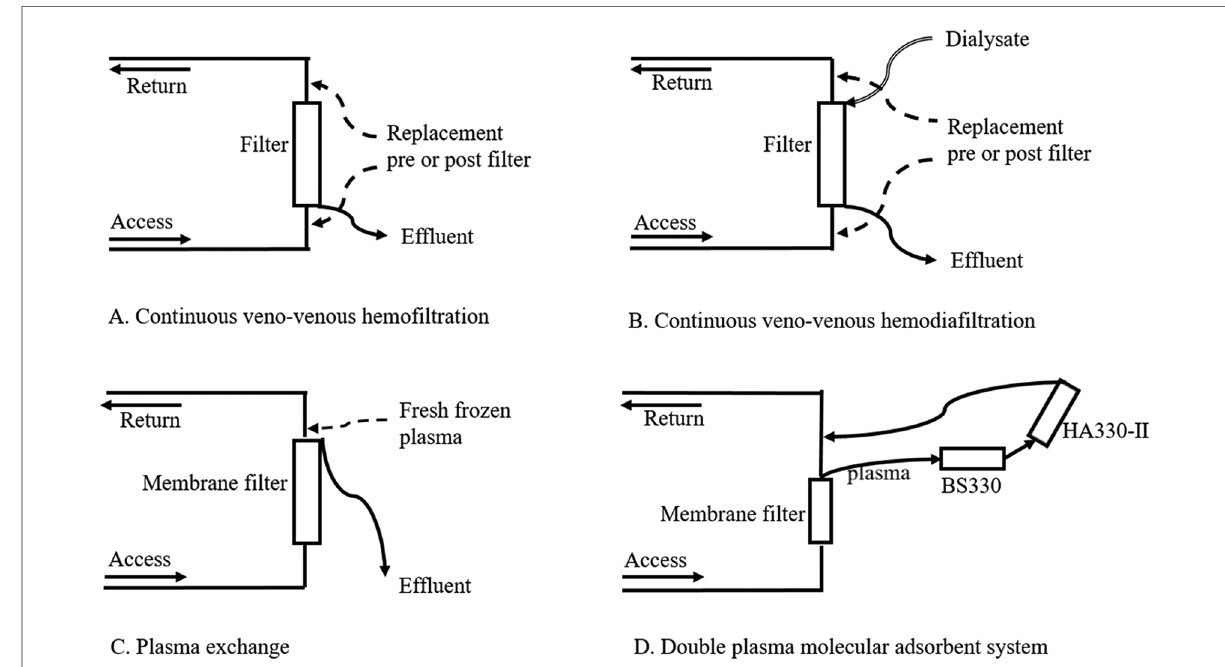
FIGURE 1 Schematic diagrams of different modalities of arti fi cial liver support